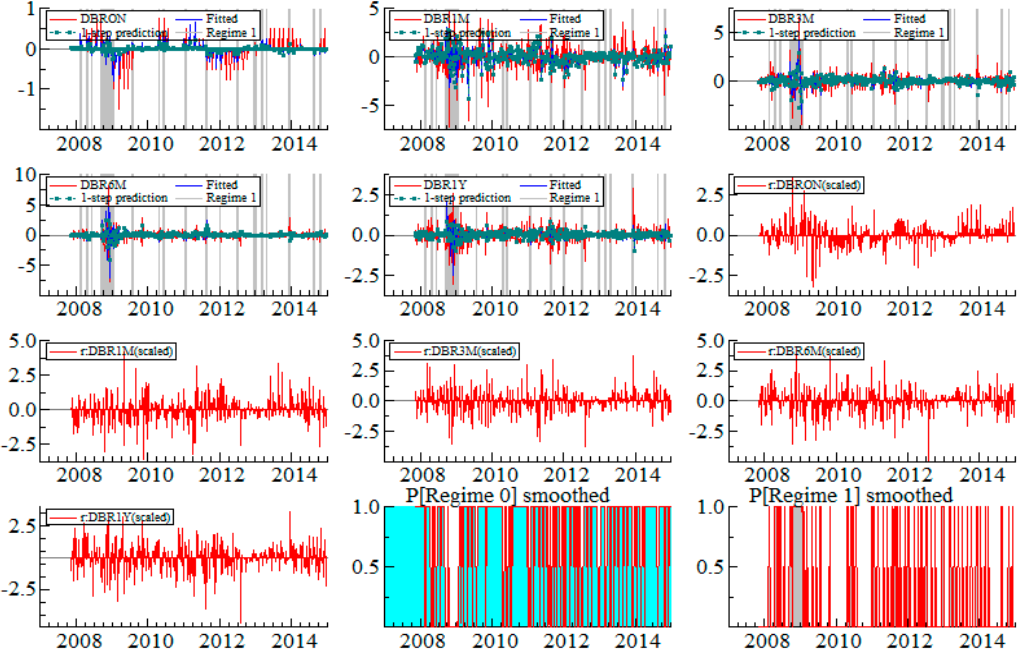
Figure A5. Brazil Regime-switching modeling: Msiah (2)-Vecm (2). Note: Regime 1 denotes the high-volatility regime, whilst Regime 0 the low-volatility one [8,25].